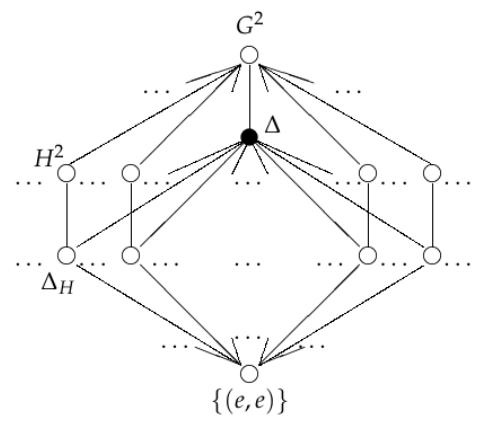
Figure 6. Weak congruence lattice of a Tarski monster